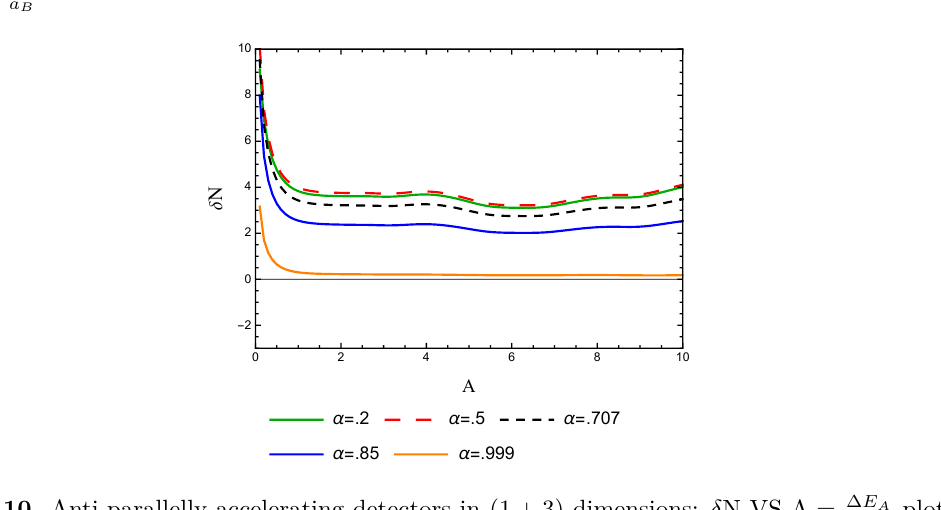
Figure 10 . Anti-parallelly accelerating detectors in (1 + 3) dimensions: δ N VS A = ∆ E A different fixed values of the coefficient α with ∆ E B